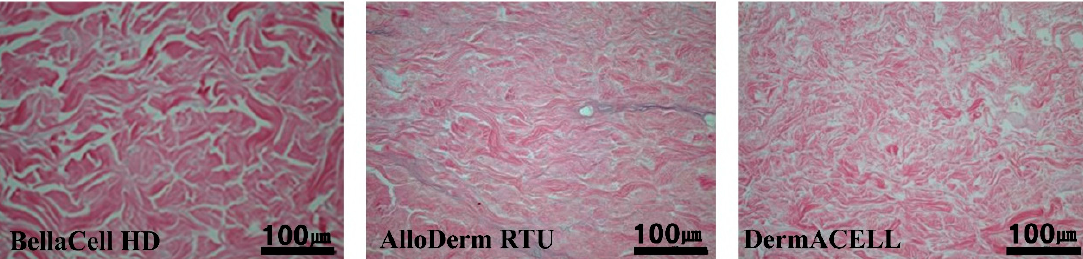
Figure 1. Decellularization assessment. The extracellular matrix of acellular dermal matrices (ADMs) was assessed by H&E staining (scale bar = 100 µ m). The BellaCell HD and DermACELL display complete decellularization while the AlloDerm Ready to Use (RTU) shows cellular debris between the figures.